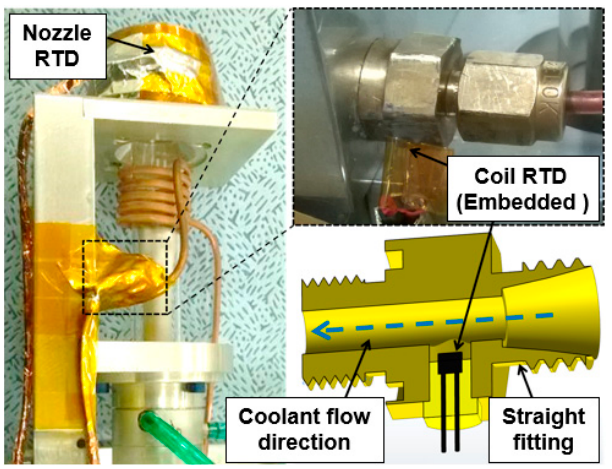
Figure 6. Instrumented plasma torch using RTD